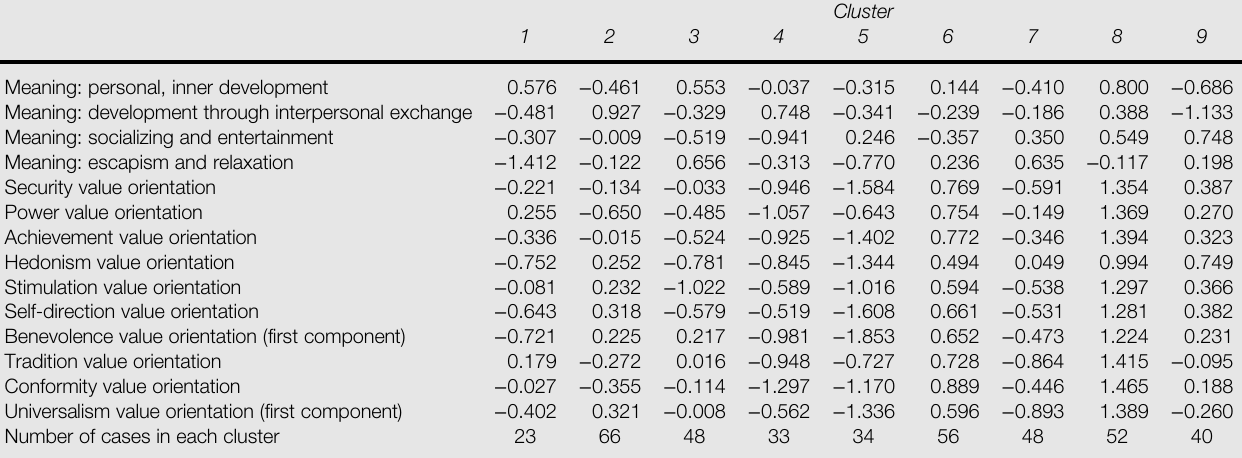
Table V Clusters of young people: the number of cases and Final Cluster Centres processed from sampled